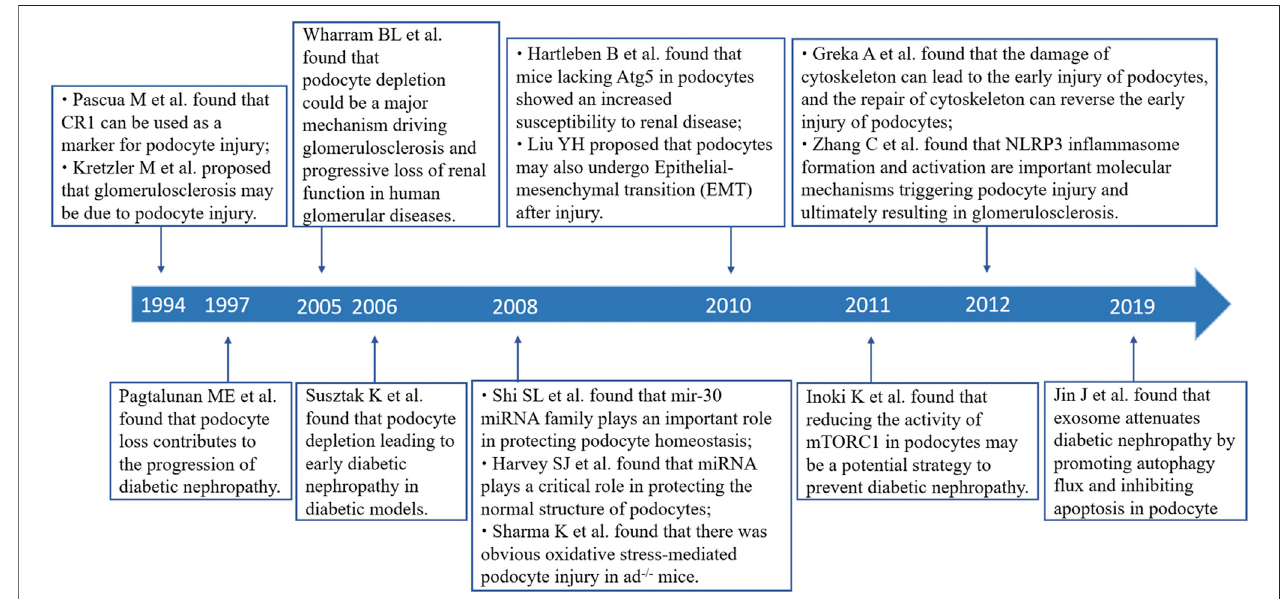
FIGURE 7 | Timeline of part of landmark achievements in podocyte injury